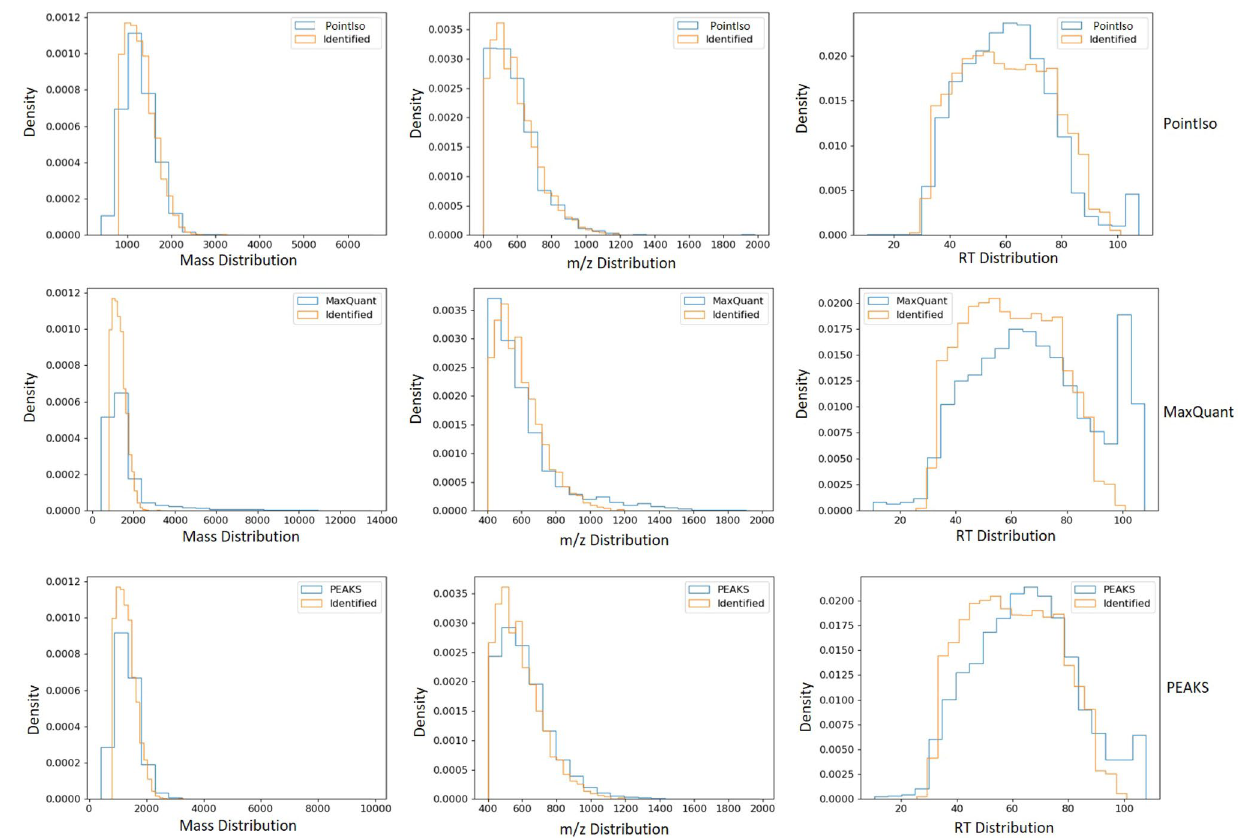
Figure 3. Comparison of mass, m / z , and RT distribution of detected features (blue) and identified features (orange) for different tools. First, second, and third rows of plots are representing the result for PointIso, MaxQuant, and PEAKS respectively (distributions for other tools are included in Supplementary Fig. S3). The orange distributions remain the same along the column since its representing the identified peptides. Plots in the first column show that all algorithms might have some false positives below 1000 Da mass, but the rate is lowest for PointIso. MaxQuant may have some false positives above 2000 Da as well. Then the second column is representing the distribution of m / z . Again, MaxQuant might have some false positives in the higher range of m / z . Finally, the third column is presenting the distribution of RT and all the tools have a probability of detecting false positives above 100 min RT, but that rate is lowest for PointIso. Besides that, both MaxQuant and PEAKS might report some false positives below 30 min RT. For PointIso, the histograms of detected features (blue) are showing good alignment with the histograms of identified features (orange) and support the correctness of the detected